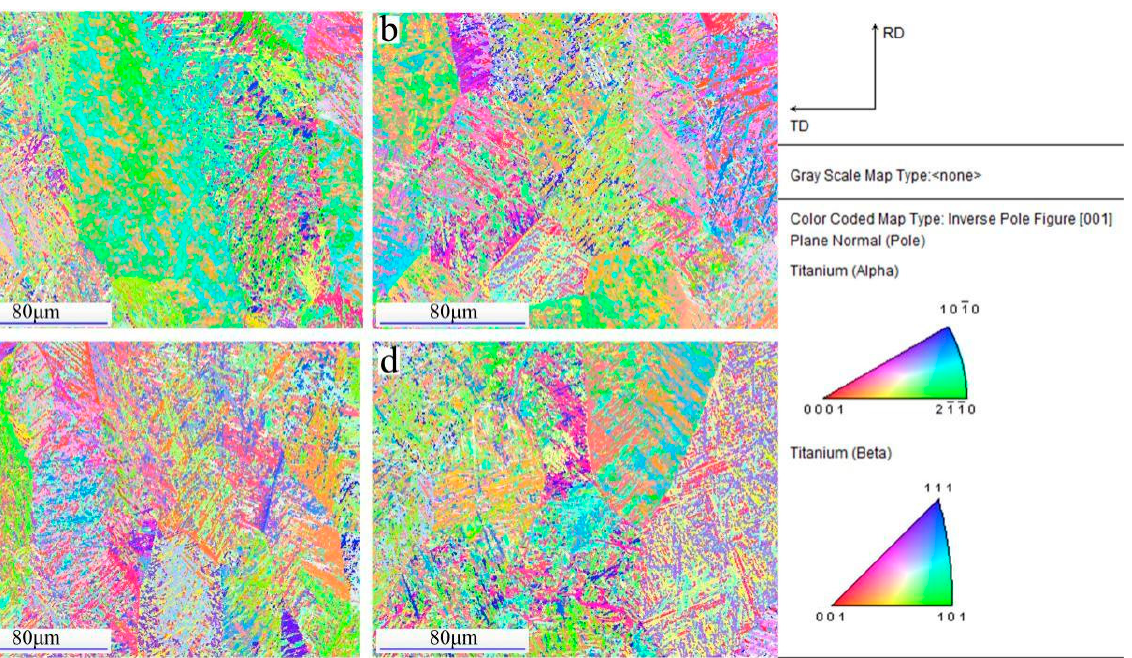
Figure 6. Phase distribution of titanium alloy DED-AAM component with the wire feeding speed of 7 m/min: ( a ) I M = 0 A, ( b ) I M = 1 A, ( c ) I M = 2 A, ( d ) I M = 3 A.